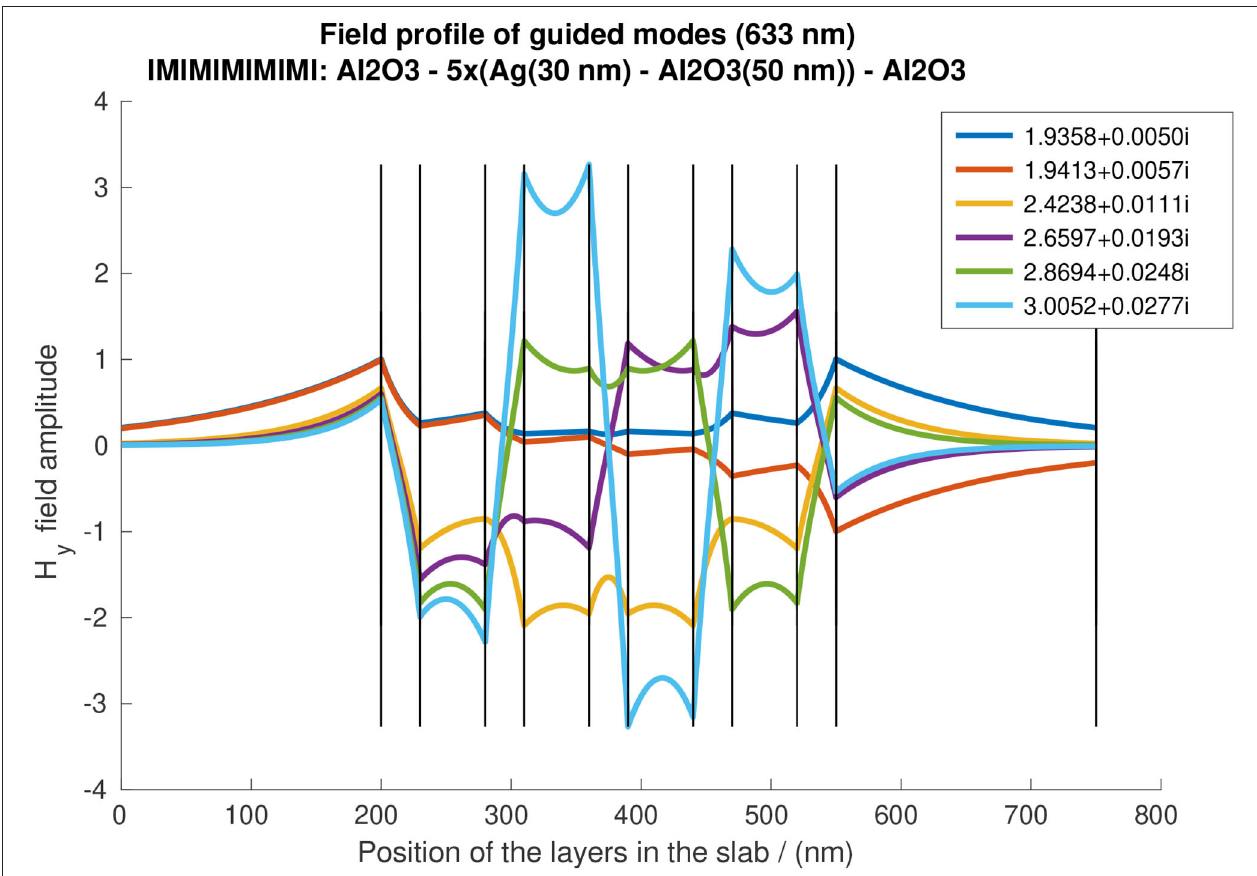
FIGURE 7 | Profiles of the field component H y for λ 633 nm along the stack of 5 silver layers of 30 nm thickness, separated by aluminum oxide layers of 50 nm = thickness. The first two lines correspond to the H y with symmetric and antisymmetric profile, respectively. The two modes have maximum amplitude at the external boundaries. By contrary, the bulk modes have increasing amplitudes with increasing k r . The vertical black lines indicate the boundaries between